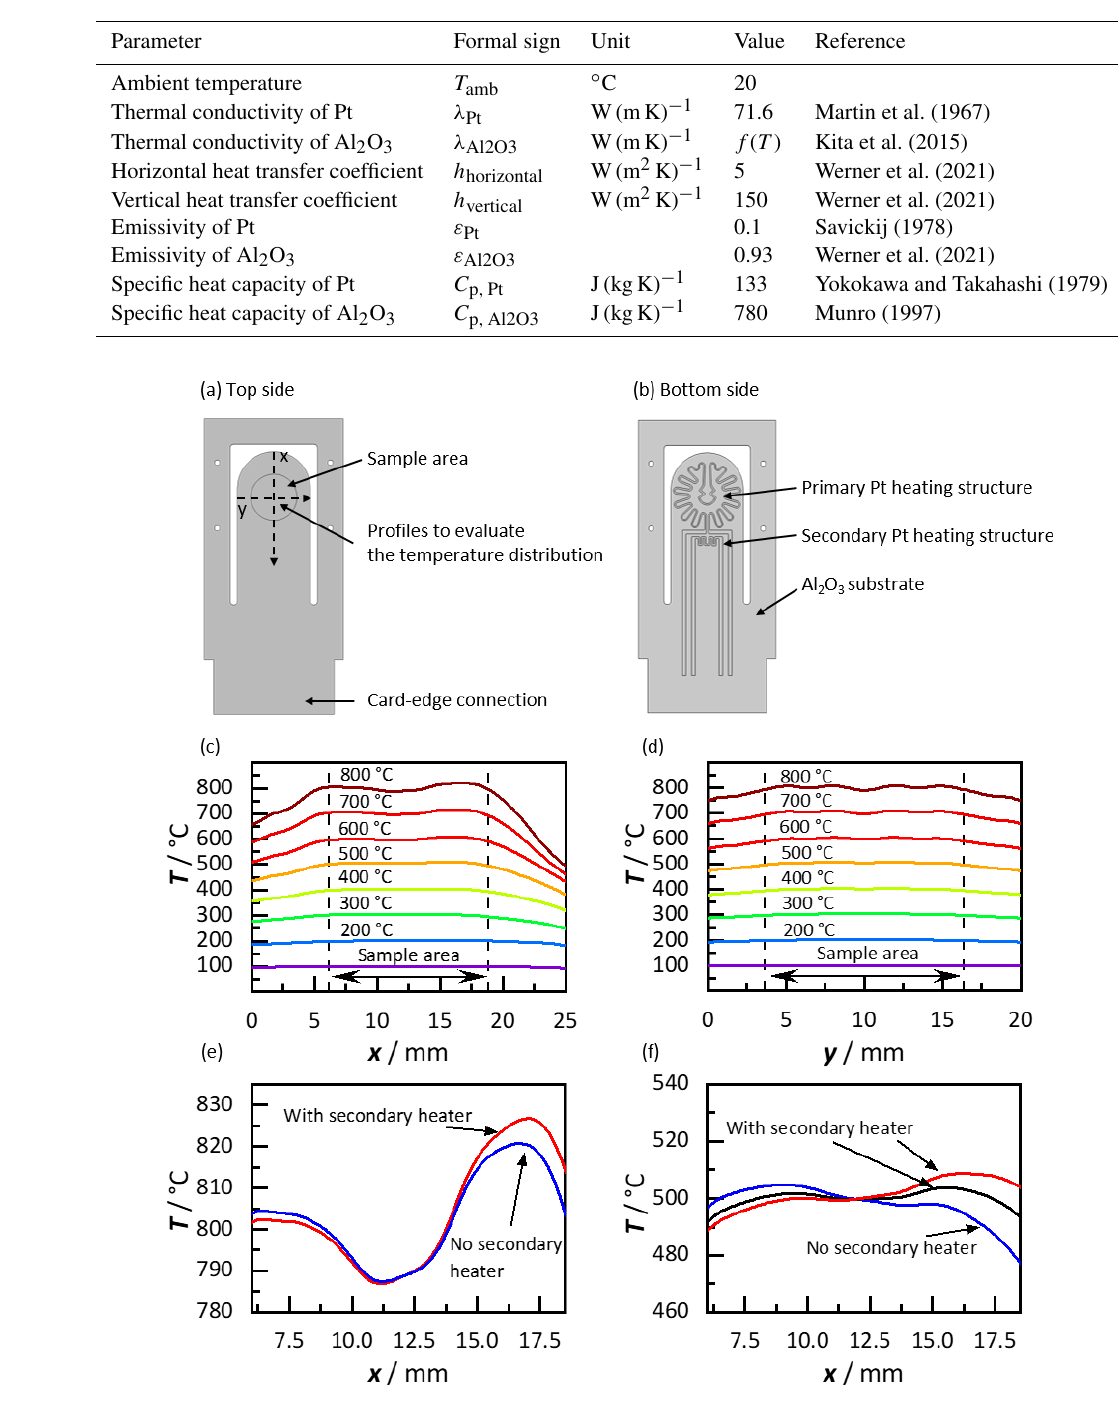
Figure 3. Simulation of the temperature distribution of the new heating structures. (a) Top view of the simulation model with sketched profiles for the evaluation, (b) bottom side of the sample holder with primary and secondary heating structure, (c) temperature profiles along the x axis at different temperatures, (d) temperature profiles along the y axis, (e) temperature profile with and without secondary heater at 800 ◦ C, and (f) temperature profile with and without secondary heater at 500 ◦